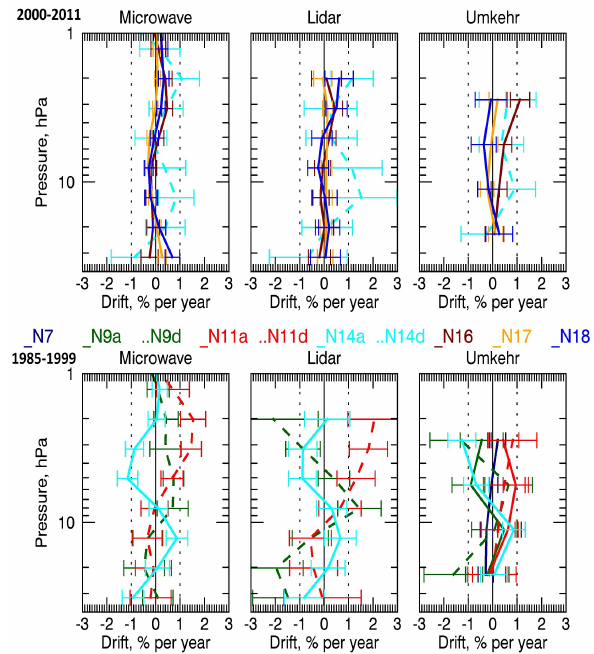
Fig. 14. Vertical profiles of mean drifts for individual SBUV in- struments relative to each type of ground-based instruments: (a, d) microwave spectrometers; (b, e) lidars; (c, f) Umkehr instruments. The mean drifts are calculated as the mean of regressions at all considered stations weighted by the corresponding standard devia- tions. The horizontal error bars indicate the 2 σ standard deviation of the slope. Colors correspond to individual SBUV instruments, and dashed lines correspond to descending modes. The top row shows drifts over the time period from 2000 to 2011 and the bottom row over the period from